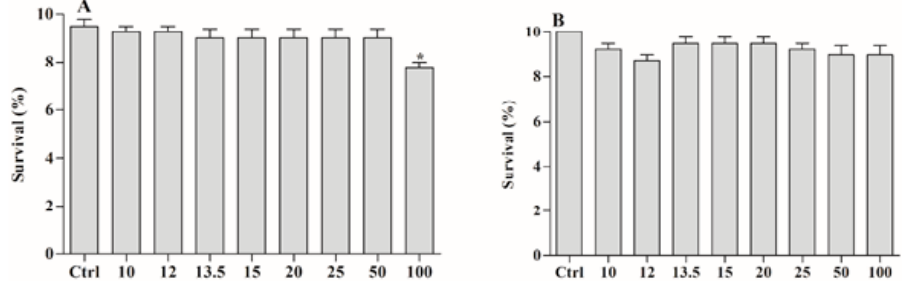
Figure 6. Toxicity of ether extract ( A ) and BAR ( B ) on Artemia salina . The ctrl was 0.5% ethanol and seawater. * p < 0.05.